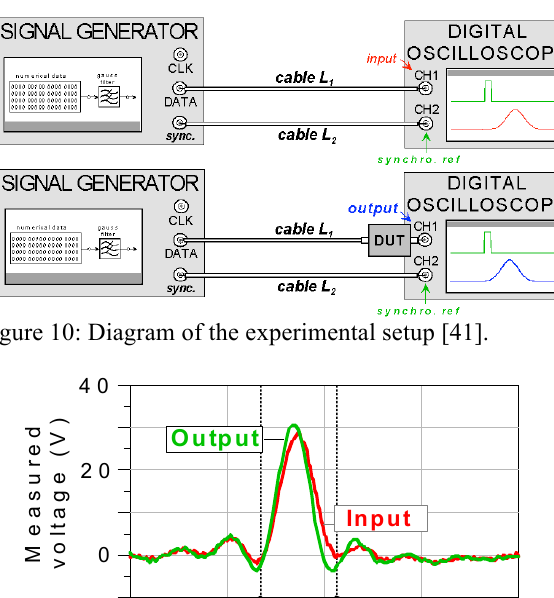
( s ) for the passive circuit, T d ( s ) for the cascaded NGD